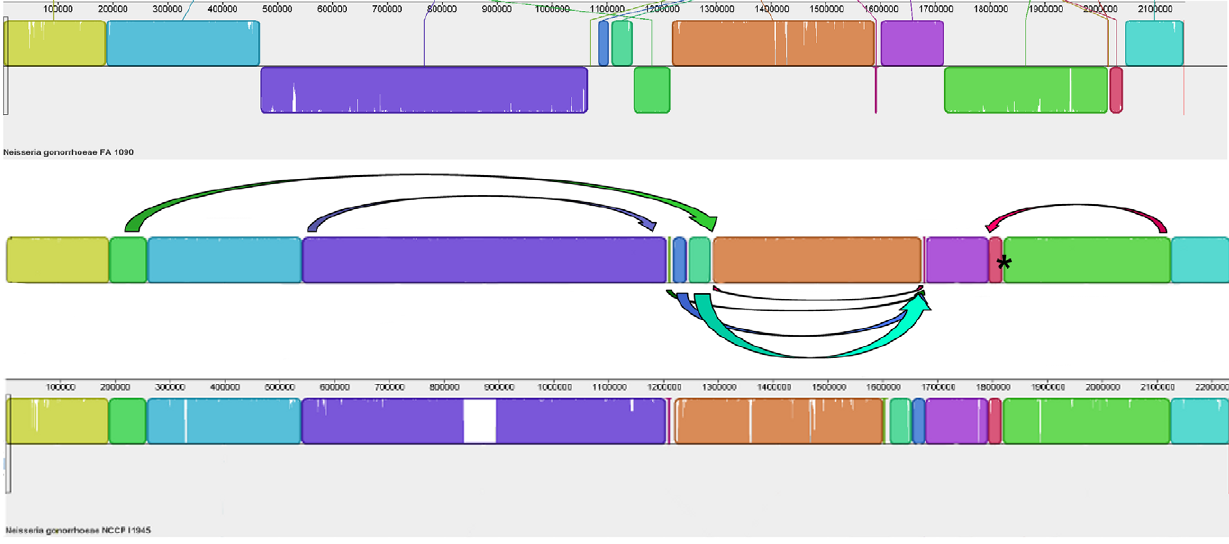
Figure 6. Model for the chromosomal rearrangements observed in N.gonorrhoeae strains NCCP11945 and FA1090. Alignments of the genome sequence data shows that the organisation of the genomes of strains NCCP11945 and FA1090 are different (Figure 1). Analysis of this data reveals that the most likely original order of the genome is that shown in the centre of this figure from left to right as blocks 1 (yellow), 2 (green), 3 (light blue), 4 (purple), 7 (lime), 9 (blue), 8 (teal), 6 (orange), 5 (pink), 10 (violet), 11 (red), 12 (too small to be visible), 13 (too small to be visible), and 14 (bright green), circularising back to block 1 (aqua). In strain FA1090 (top), IS1106-mediated homologous recombination and ISNgo2 mediated reintegration have caused a translocation and inversion of block 2 (green arrow), SSREE-mediated homologous recombination has inverted block 4 (purple arrow), and CREE-mediated homologous recombination has inverted blocks 11–14 together (red arrow). In strain NCCP11945 (bottom), ISNgo2 mediated excision and reintegration have caused the translocation of block 7 (lime arrow), block 9 (blue arrow), and block 8 (teal arrow), and the displacement of block 5 (pink arrow).